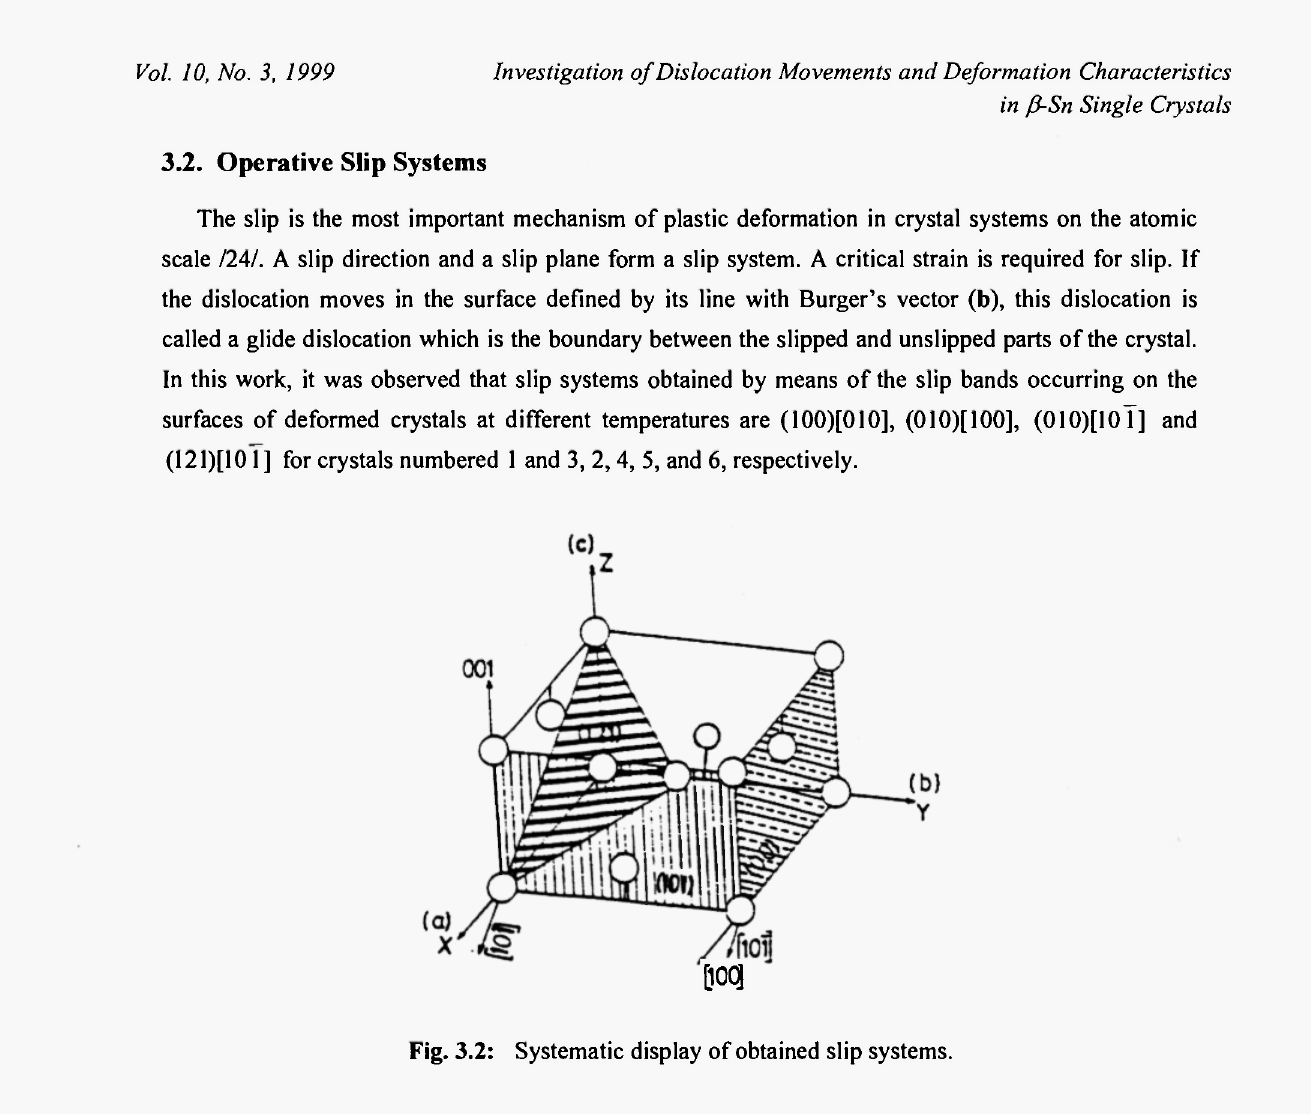
Fig. 3.2: Systematic display of obtained slip